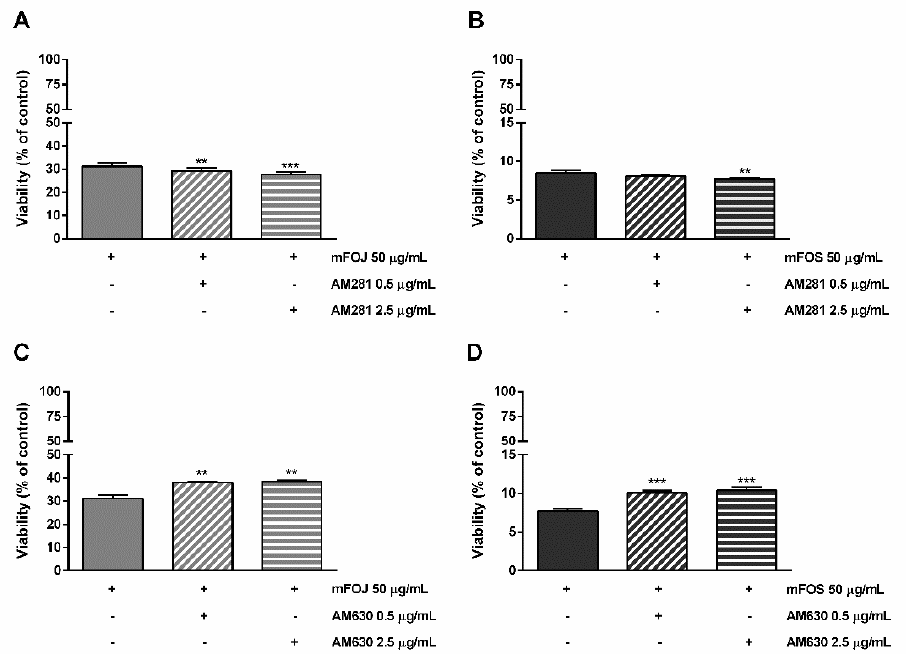
Figure 7. Cytotoxicity of the mFOJ and mFOS cocktails (containing the same concentrations of nonintoxicating phytocannabinoids and caryophyllane sesquiterpenes determined in 50 µg/mL FOJ and FOS) after treatment with 0.5 and 2.5 µg/mL AM281 ( A , B ) and AM630 ( C , D ), in MDA-MB-468 breast cancer cells. The cells were subjected to a 1 h pre-treatment with the antagonist, then incubated with the tested samples for 24 h. Data are expressed as mean ± SEM of at least three independent experiments with three technical replicates ( n = 9); ** p < 0.01 and *** p < 0.001, significant difference respect to the control (ANOVA + Dunnett’s Multiple Comparison PostTest).